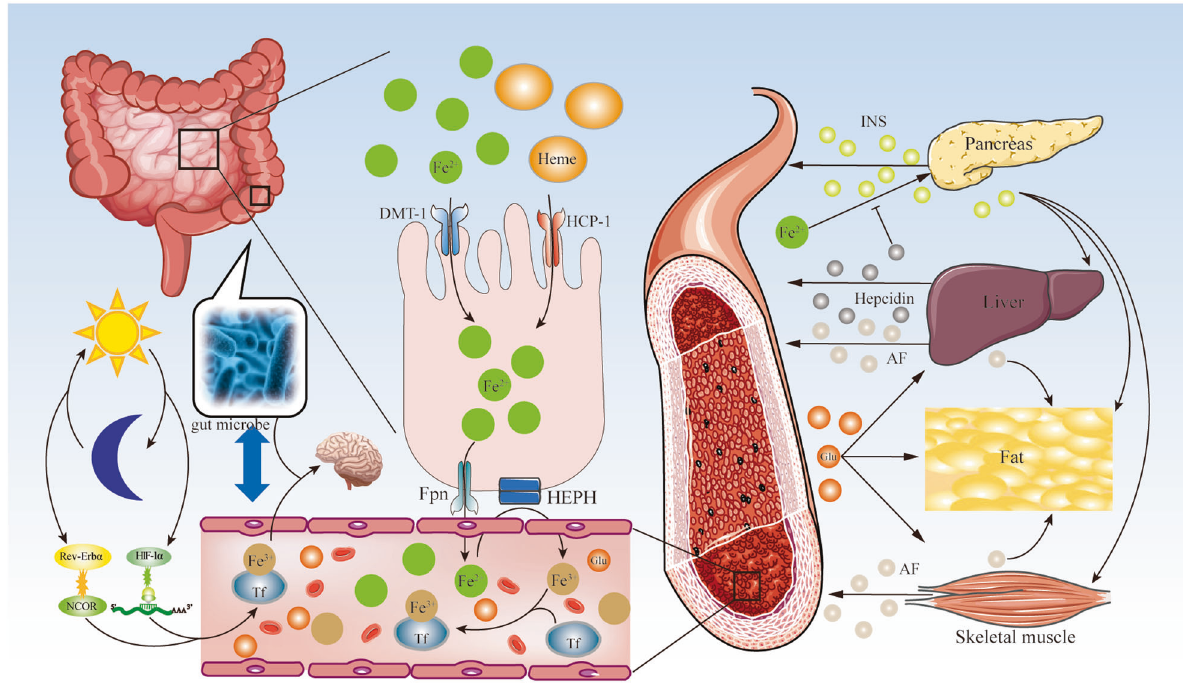
Fig. 1 Flow chart of the study. Iron metabolism. Iron is absorbed by intestinal cells in the form of free divalent iron (Fe 2 + ) or heme iron (Heme) in the intestine. Fe 2 + is absorbed by intestinal cells through divergent metal transporter 1 (DMT-1). Heme iron is transported to intestinal cells through heme carrier protein 1 (HCP-1). Fe 2 + is released into the blood capillary through ferroportin (Fpn), oxidized into free ferric iron (Fe 3 + ) by hephaestin (HEPN), combined with transferrin (Tf) in the circulation, and transported to organs and tissues. Fe 3 + enters the pancreas, liver, fat, and skeletal muscle to regulate blood glucose (Glu) homeostasis. Pancreas β Cells release insulin (INS) in response to the stimulation of Glu. INS affects the liver, fat, and skeletal muscles. The liver and skeletal muscles release adipose factor (AF), which regulates adipose tissue metabolism. On the other hand, iron metabolism also in fl uences the composition of the gut microbiota, which may affect cognitive through the gut-brain axis. Iron affects circadian glucose metabolism via the regulation of the interaction of nuclear receptor subfamily 1 group d member 1 (Rev-Erb α ) with its co-suppressor, nuclear receptor corepressor 1 (NCOR). iron also participates in the regulation of β -cell function mediated by HIF-1 α in circadian